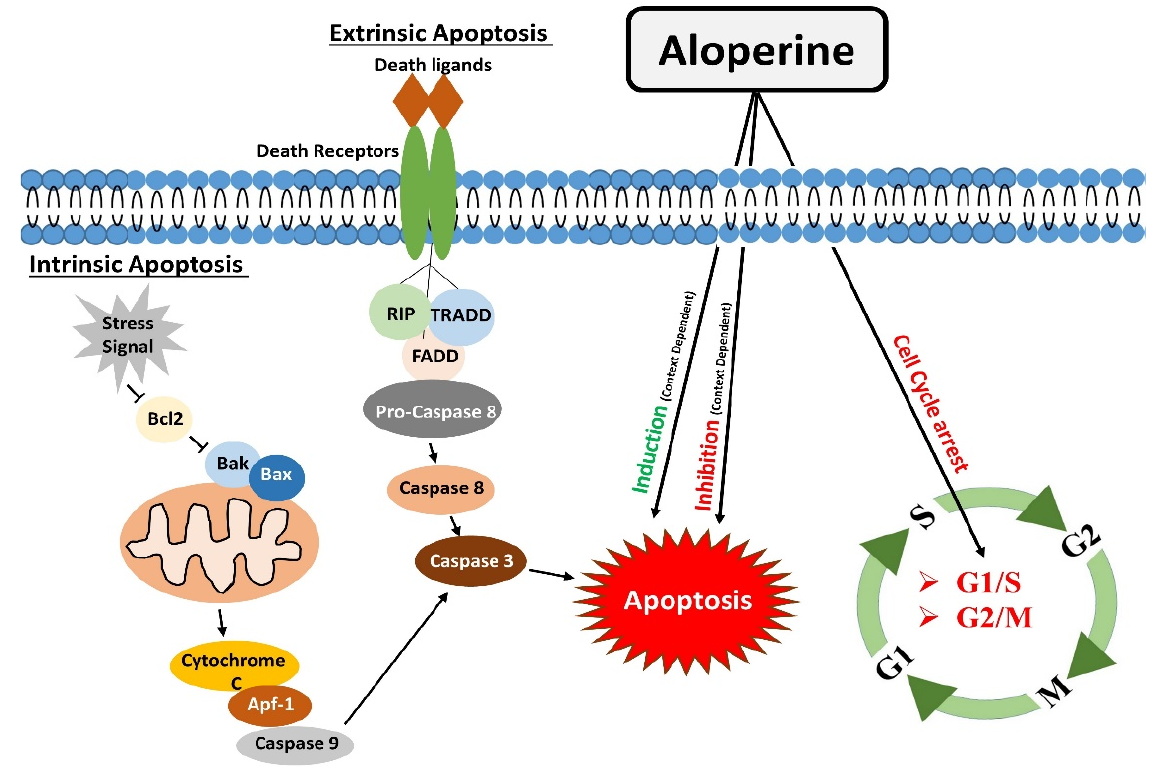
Figure 1. Modulatory effects of aloperine on apoptosis and cell cycle.